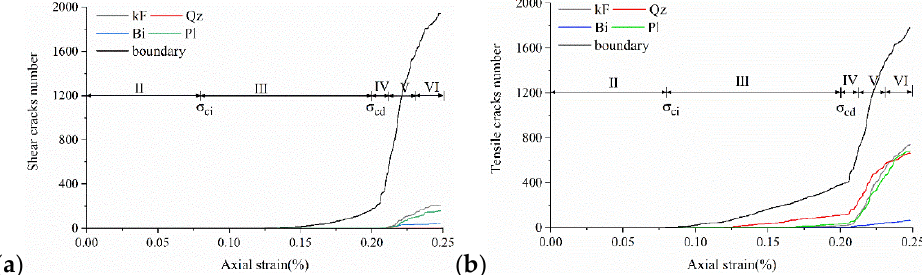
Figure 13. Variation curves of Boundary cracks and transgranular cracks at different damage stages: ( a ) The number of cracks produced by tensile failure. ( b ) The number of cracks produced by shear failure.